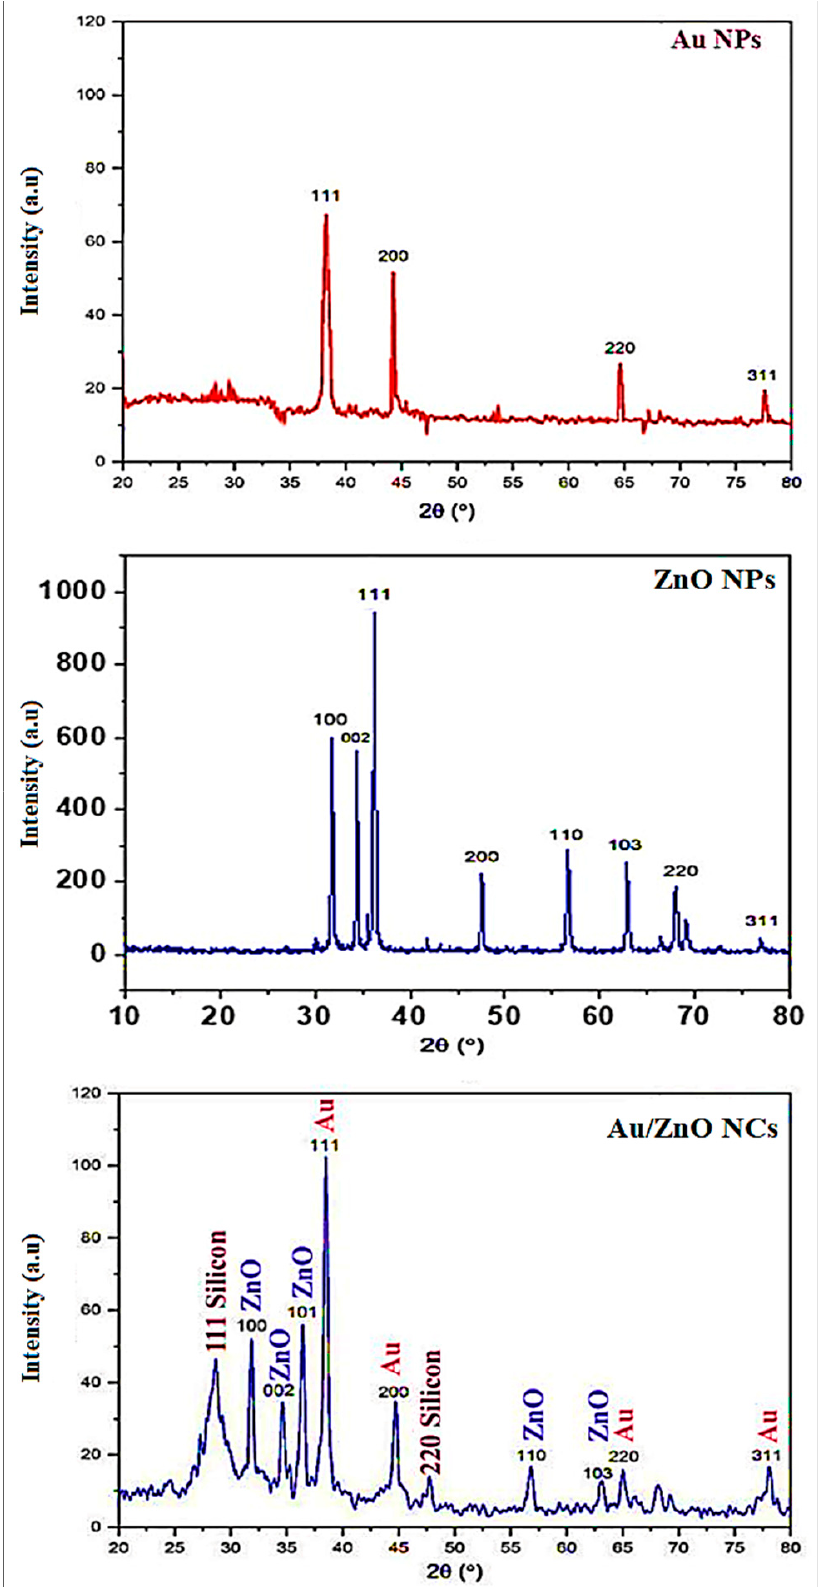
Figure 2. XRD spectra of Au NPs, ZnO NPs, and Au/ZnO NCs prepared via laser ablation at 800 mJ.